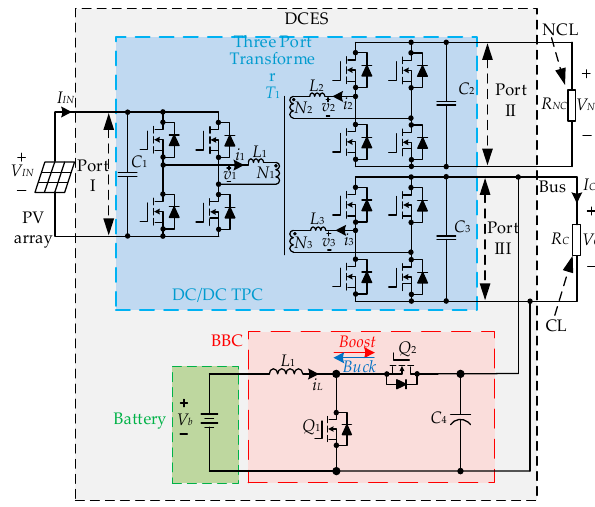
Figure 1. Critical load paralleled-energy storage unit (CLP-ESU) topology of the DC electric spring